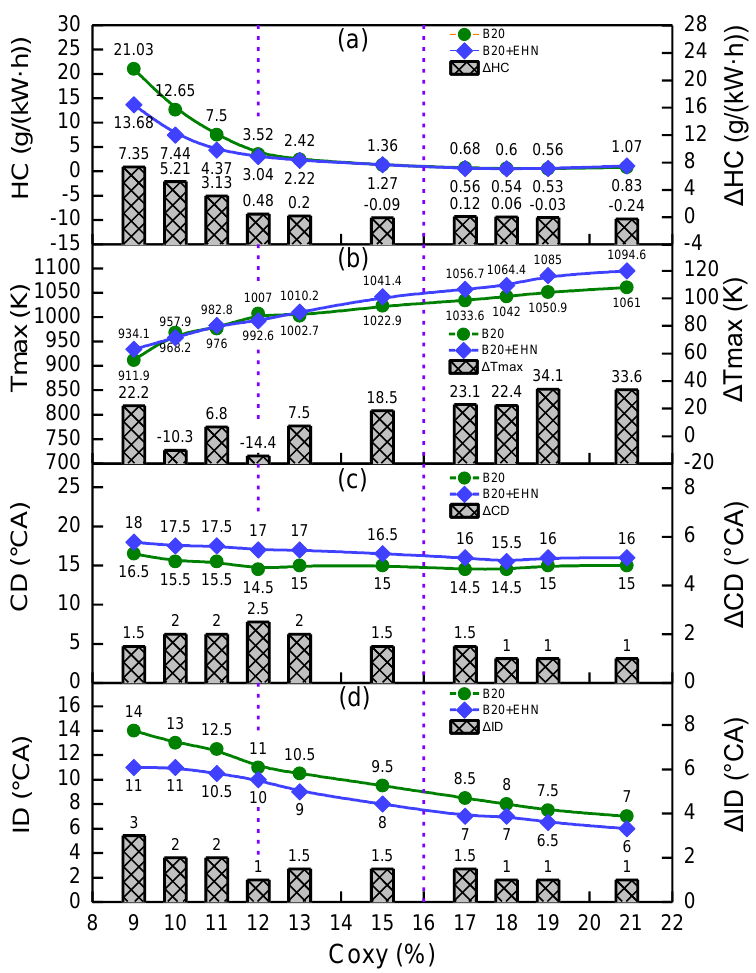
Figure 7. HC emissions and the difference ( a ), maximum in-cylinder temperatures and the difference ( b ), combustion durations and the difference ( c ), and ignition delay periods and the difference ( d ) for B20 and B20 + EHN fuels.